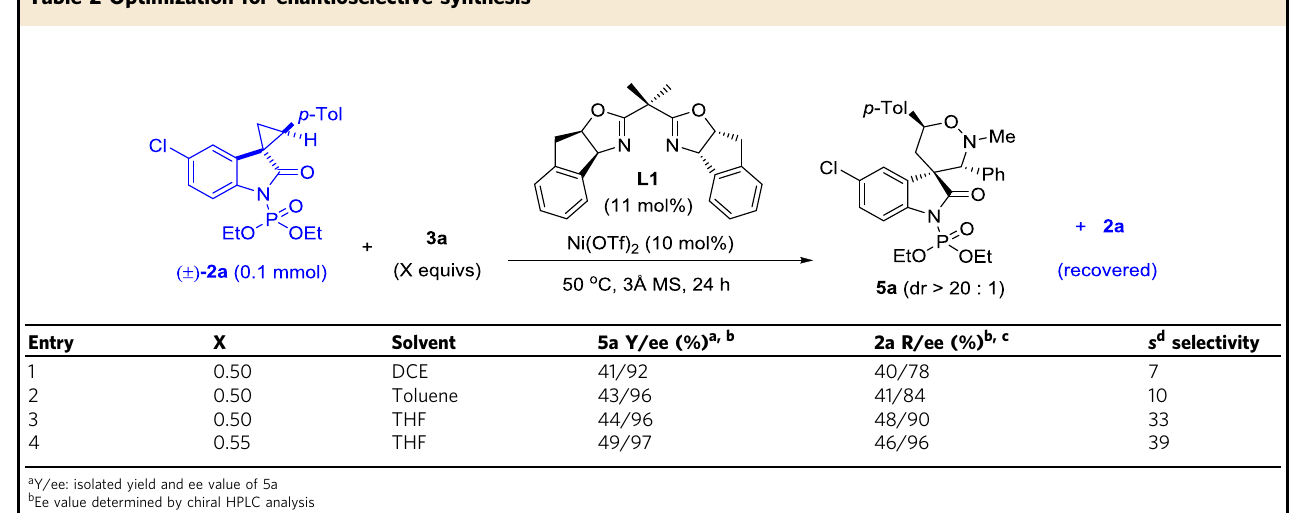
Table 2 Optimization for enantioselective synthesis